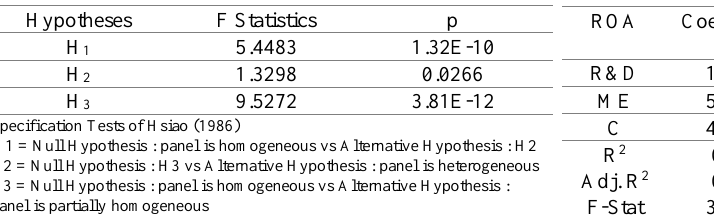
Table 12. Panel ARDL MG-CCE test results of Model 2